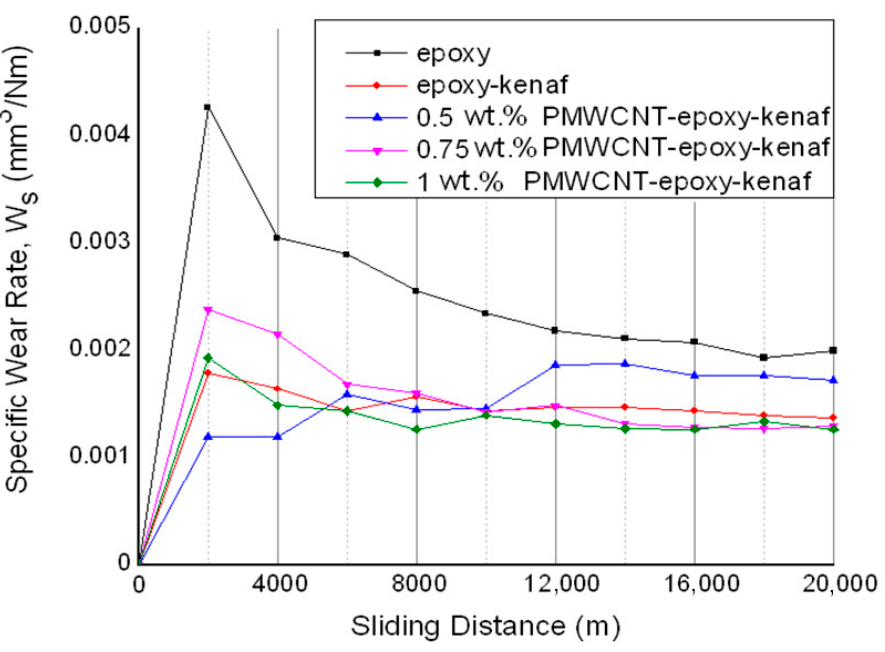
Figure 4. Specific wear rates of untreated MWCNT (PMWCNT)-filled epoxy–kenaf composites.